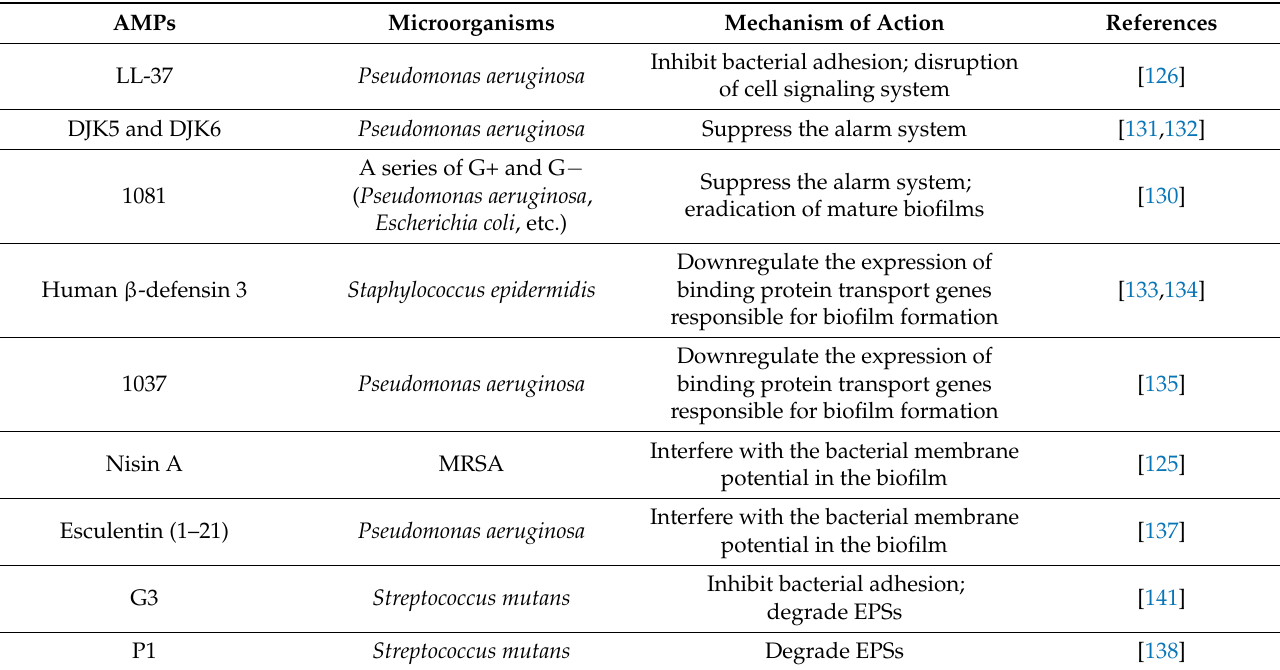
Table 3. AMPs with antibiofilm activity, including the strains and modes of